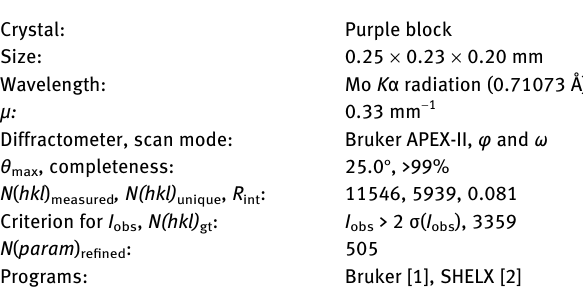
Table  : Data collection and